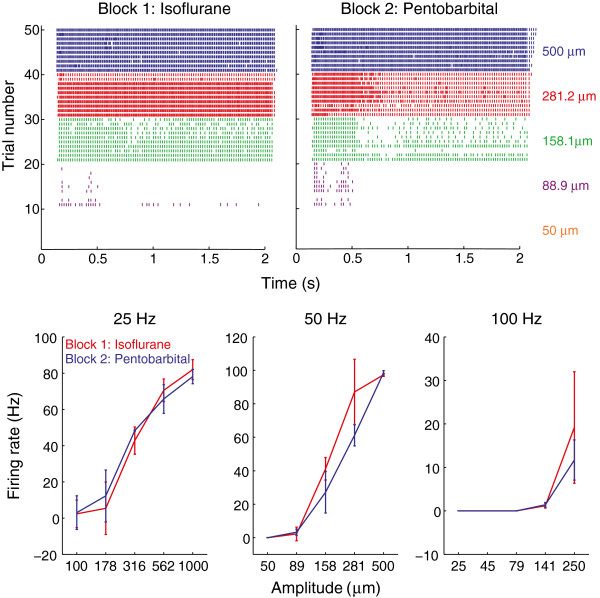
Typical responses of a single unit under anesthesia with first isoflurane and then pentobarbital. Top: Raster plots of the responses to 50-Hz stimulation under isoflurane (left) and pentobarbital (right). Each row on the raster plots represents the spike train of the single unit corresponding to a given stimulus lasting for 2 seconds. Stimuli were presented ten times at each of five amplitudes. Bottom: Mean firing rates as a function of amplitude at the three frequencies tested. Error bars denote the standard deviation.